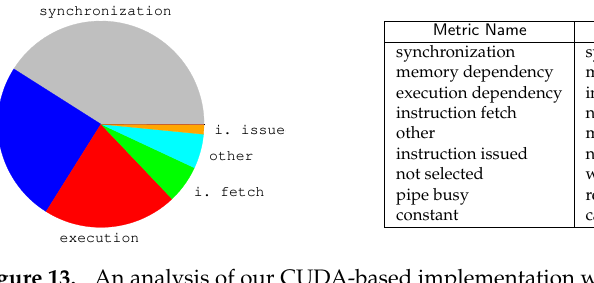
Figure 13. An analysis of our CUDA-based implementation with the NVIDIA profiling tool (Nsight). The chart represents all main reasons forcing a CUDA kernel function to stall, decreasing